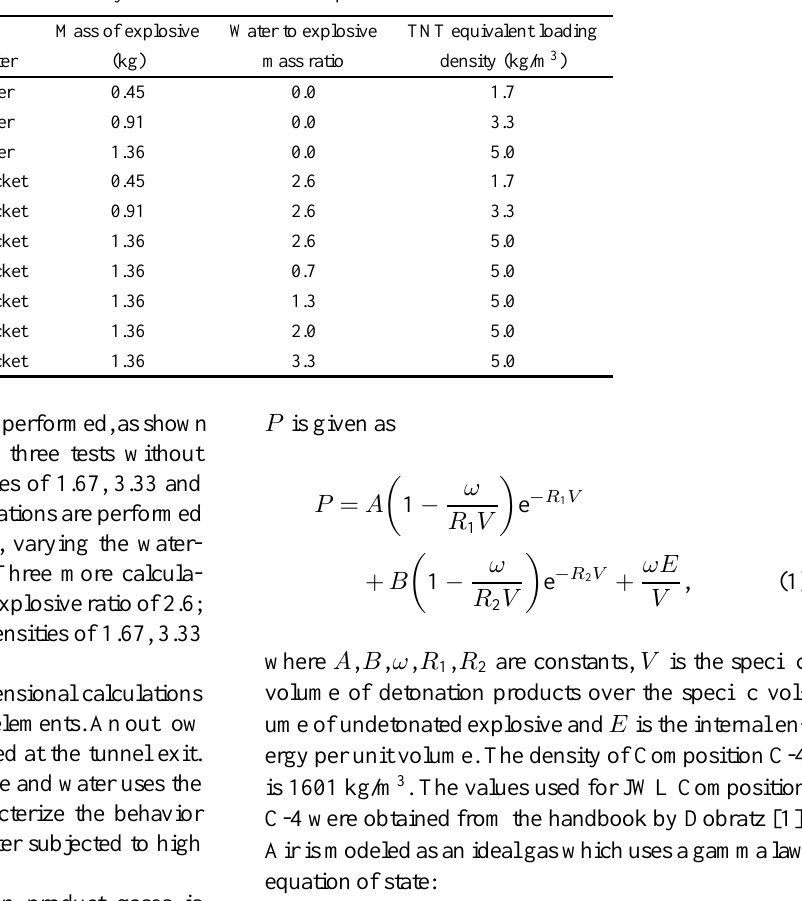
Summary of numerical calculations